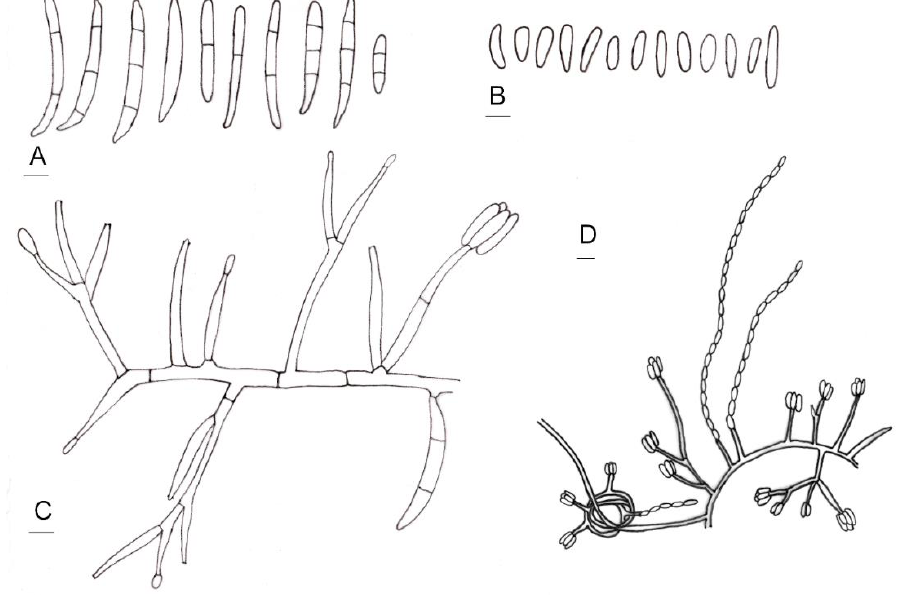
Figure 4. Line drawings of morphological characters of Fusarium curculicola . ( A ) Macroconidia. ( B ) Microconidia. ( C ) Conidiophores and conidiogenous cells. ( D ) Conidia produced in false heads and hyphae coiling in circles. Bars: 5 µm.